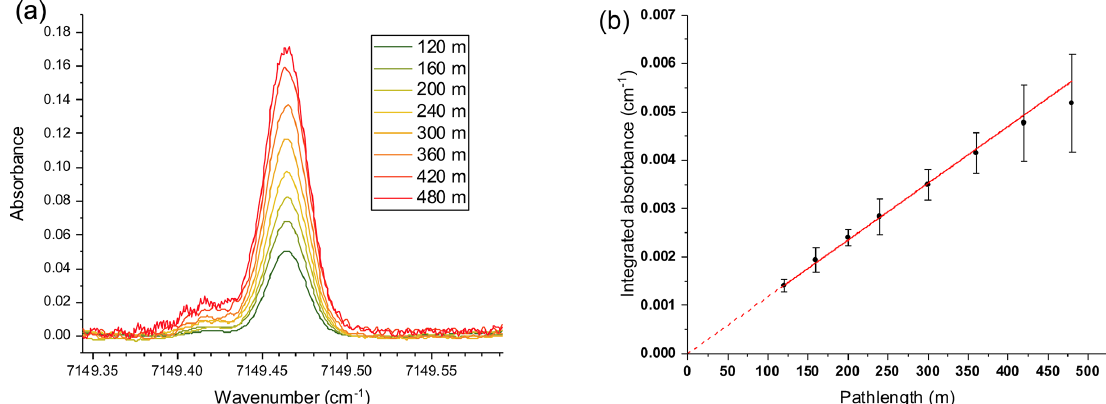
Figure 4. (a) Absorbance of the R( 17 ) rovibrational line of N 2 O in the ( 3 , 2 , 0 , 1 ) ← ( 0 , 0 , 0 , 0 ) vibrational band measured with the ECDL IR source in the 7149.5cm − 1 region for 8 different path lengths in MULTICHARME ( χ N observed at low frequency is assigned to the ECDL source which is not perfectly monomodal in this region. (b) Linear fit of path length dependence of the integrated absorbances, instrumentally weighted on the error bars deduced from the Gaussian fits of the absorbances shown in (a)